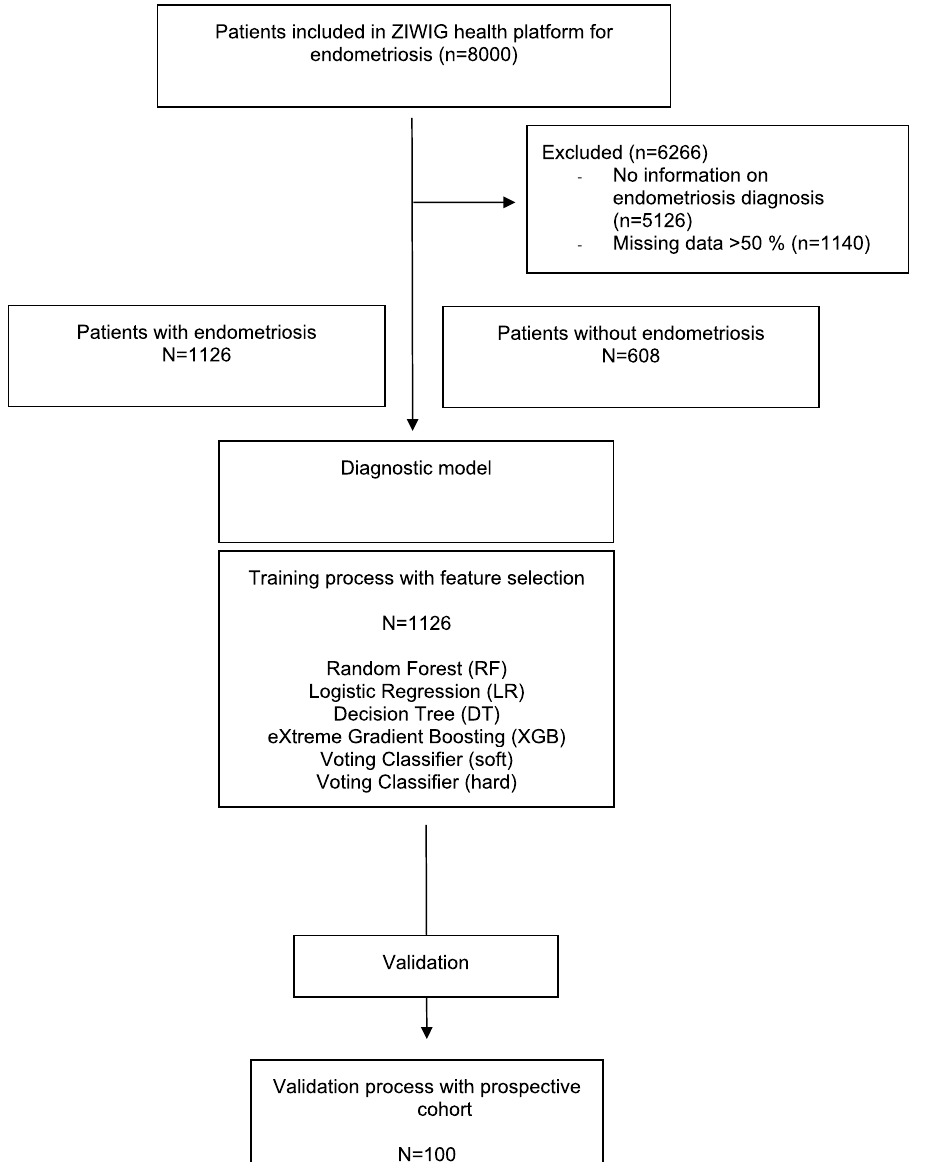
Figure 1. Flow chart of population for model development and